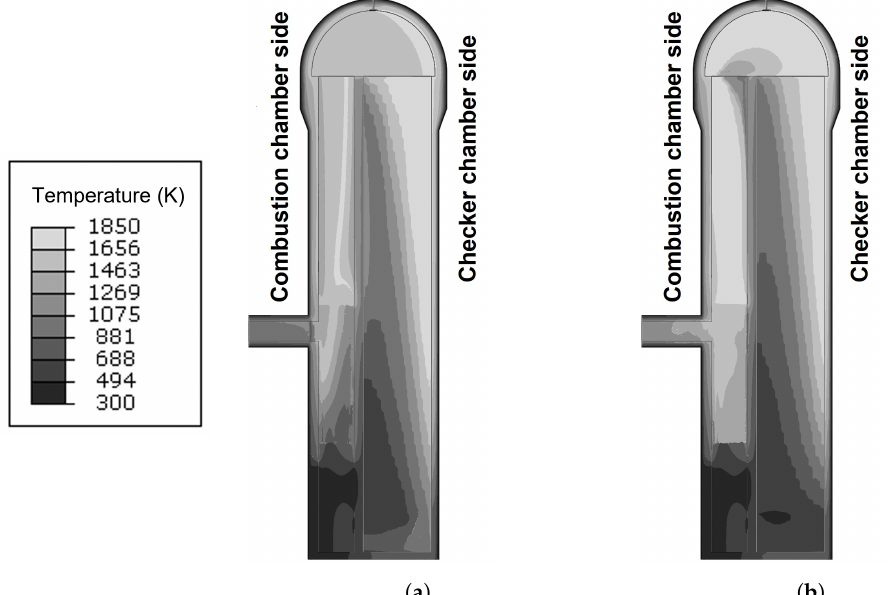
Figure 10. Temperature distributions of the refractory linings ( a ) in the middle of the on-gas period ( t = 40 min) and ( b ) the on-blast period ( t = 130 min).